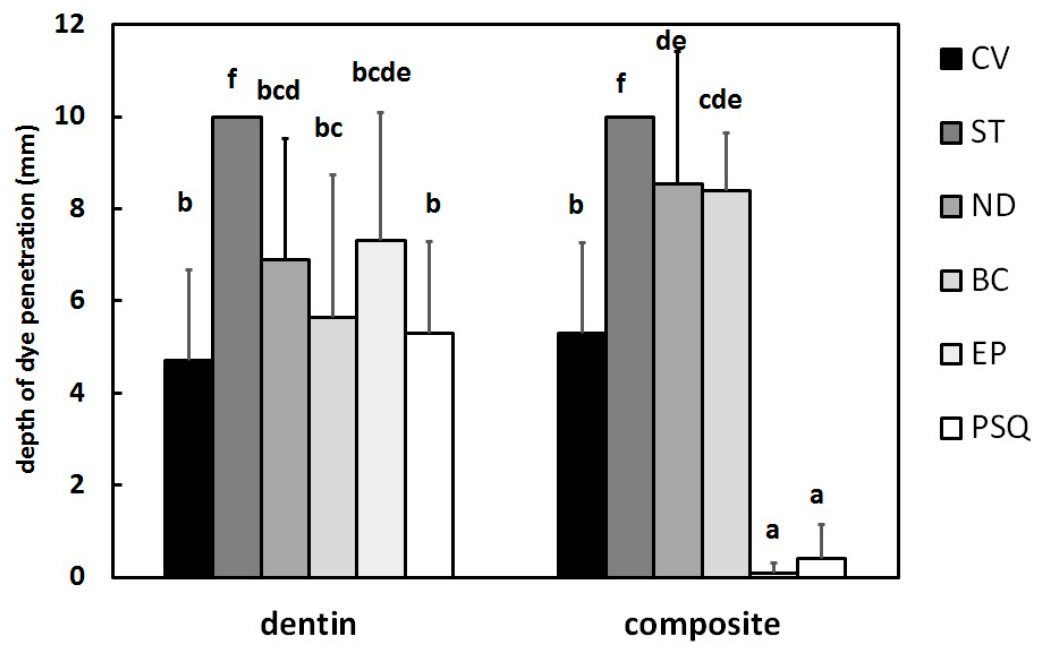
Figure 2. Depth of dye penetration in each group. Data are shown as the mean ± S.D. ( n = 10); values, with the same letter indicating that there is no significant difference between the groups ( p <